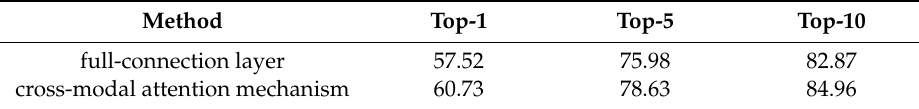
Table 4. Cross-modal attention mechanism e ff ectiveness experimental